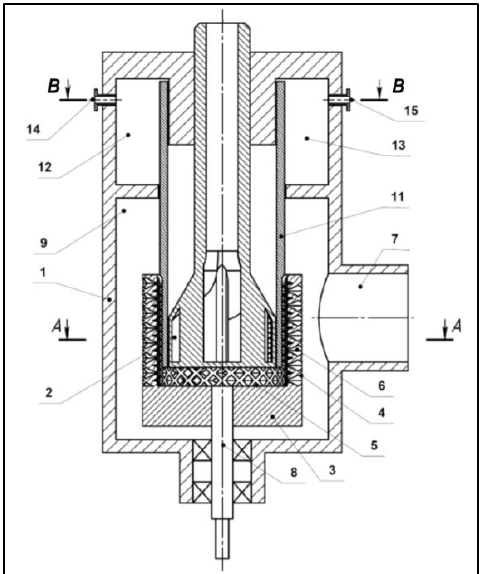
Figure 2. Schematic of the mesh turbine: 1- stator; 2- inlet nozzles; 3- rotor; 4- outer protrusions; 5- inner protrusions;